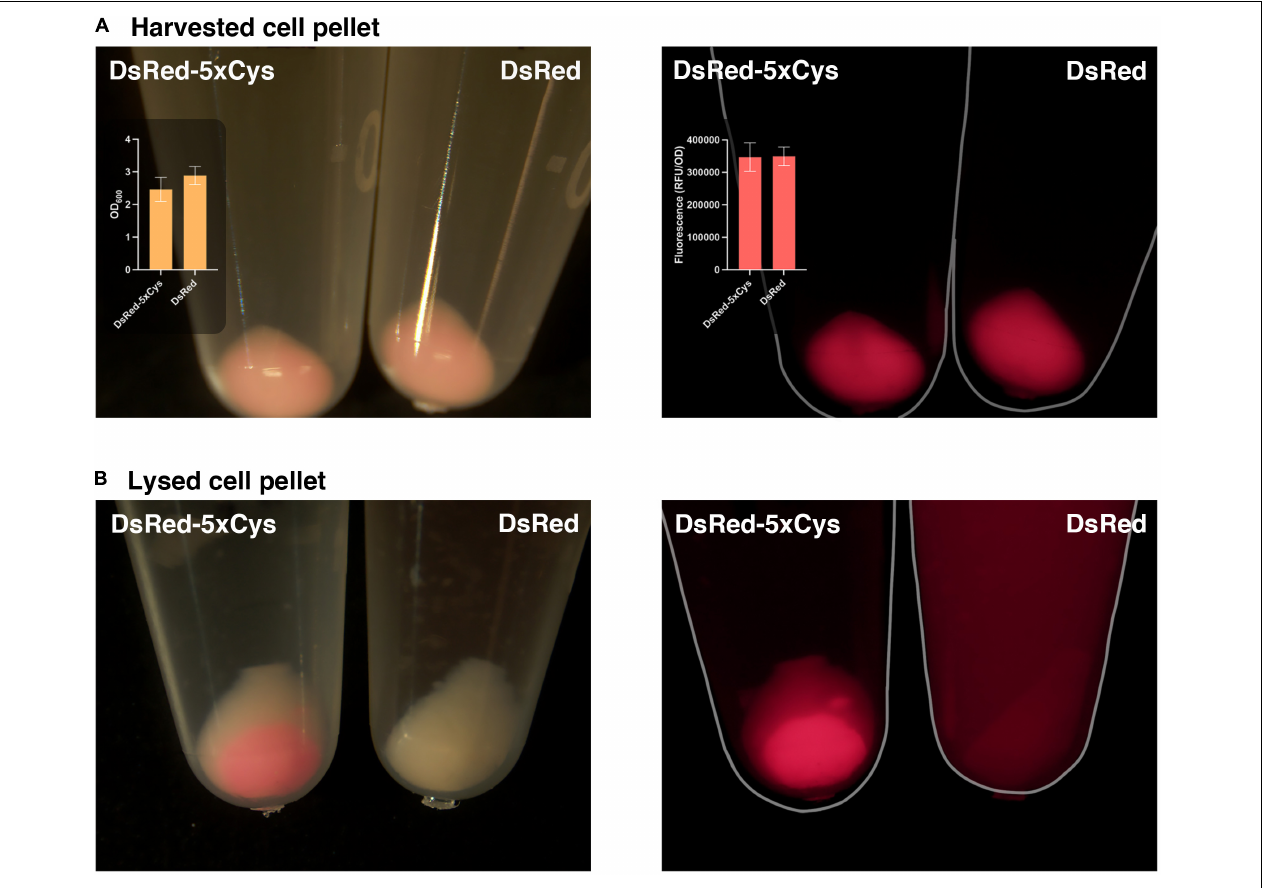
FIGURE 4 | 5xCys tag promotes inclusion body formation. (A) Harvested BL21 (DE3) cells induced with 1 mM IPTG overnight for DsRed-5xCys or DsRed expression. Left: bright view; Left inset plot: Mean OD 600 values ( n = 3); Right: fluorescent microscope, CY3 filter; Right inset plot: Mean red fluorescence (RFU/OD 600 ) ( n = 3). Error bars represent the standard deviation between replicates. (B) Cell pellets lysed with Bugbuster solution (shaking at 150 rpm for 1 h at room temperature) for soluble protein extraction. Left: bright view; Right: fluorescent microscope, CY3